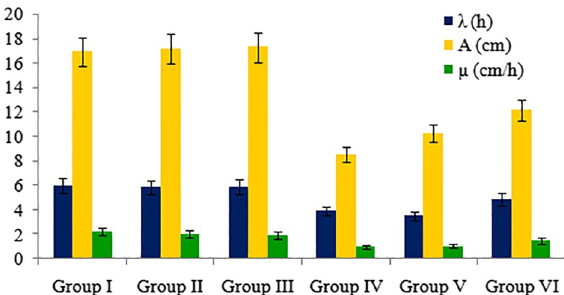
Figure 1. Effects of pendimethalin and curcumin treatments on root elongation kinetics.